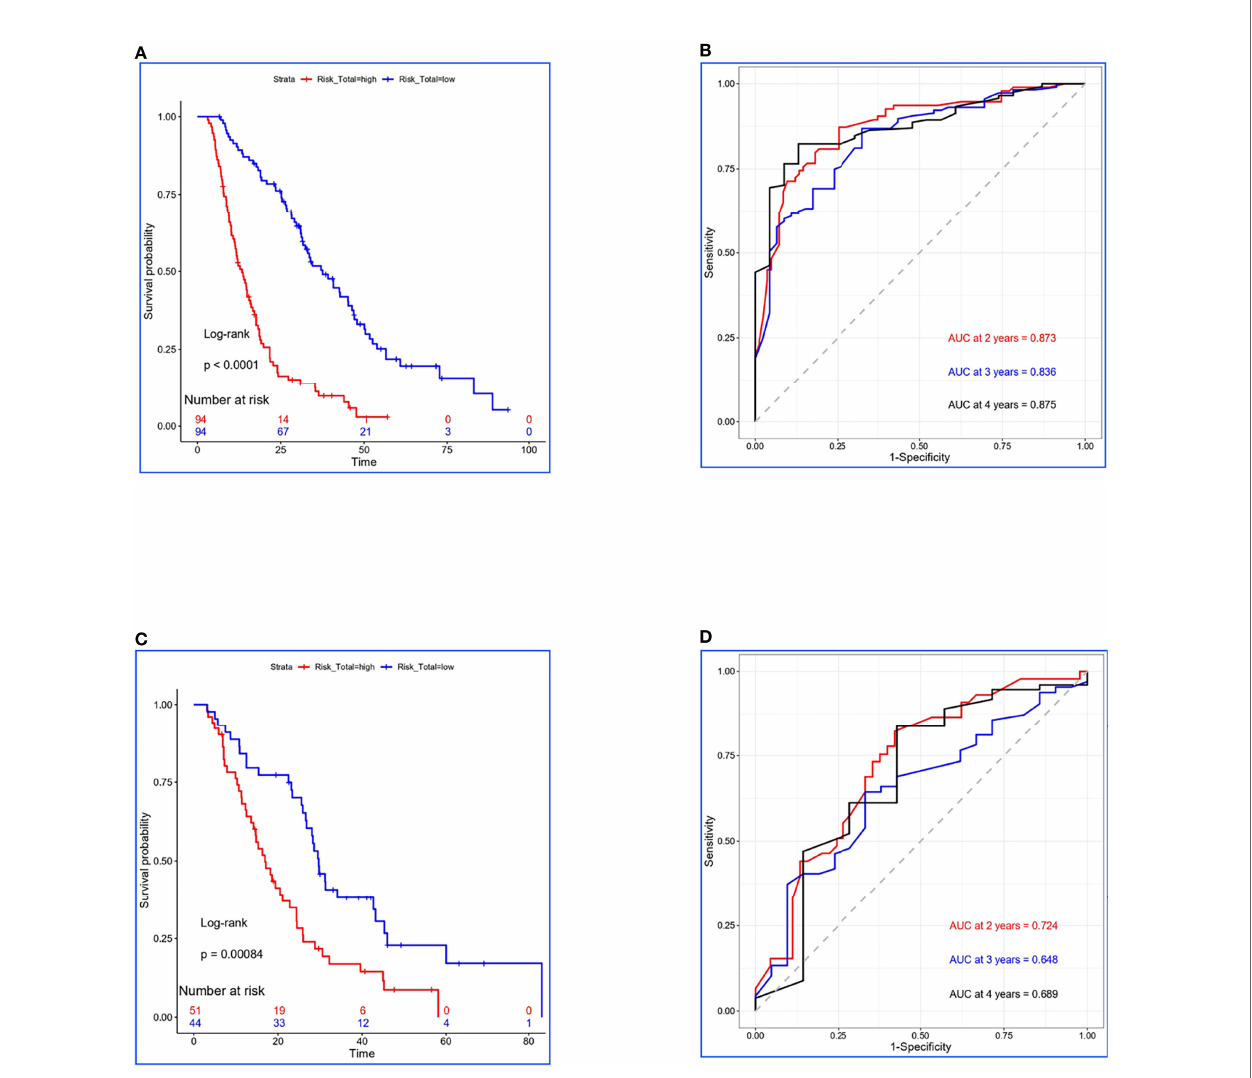
FIGURE 1 | Construction and validation for Risk-Total. (A, C) Kaplan – Meier survival analyses of Risk-Total in the training set and the validation set. (B, D) Risk-Total performance in time-dependent receiver operating characteristic (ROC) curves in the training set and the validation